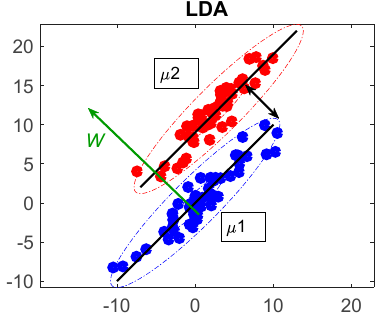
Figure 9. Visualization of the LDA idea for a 2 groups case. 2D case geometric interpretation.